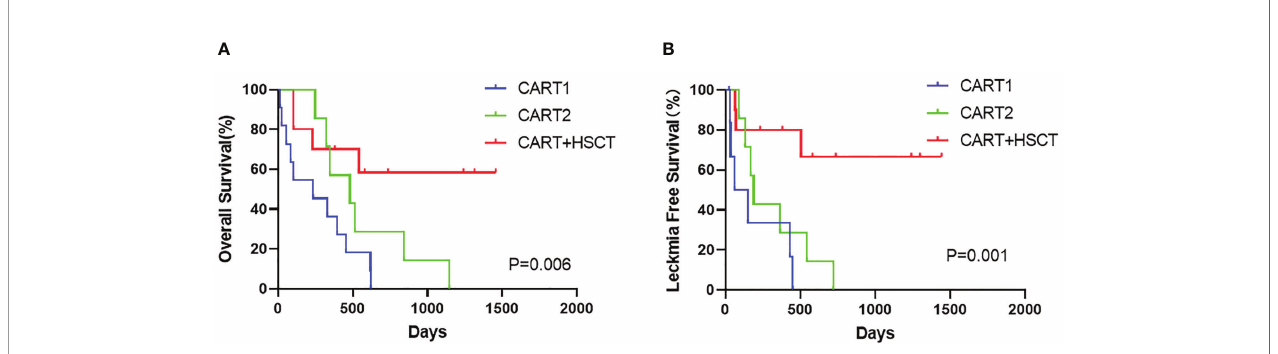
FIGURE 3 | Prognosis of patients after hCART19s therapy. (A) The overall survival (OS) of all patients after the infusion of hCART19s according to 3 groups. (B) The Leukemia-free survival (LFS) of complete remission (CR) patients according to